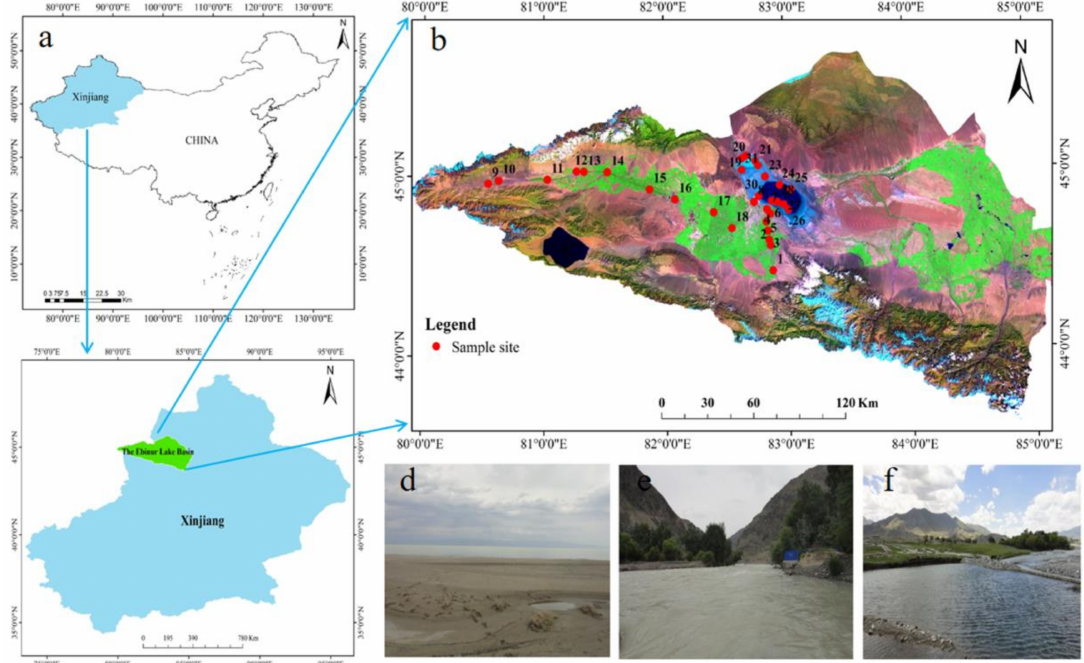
Figure 1. ( a ) Map of the locations of the Xinjiang Autonomous Region within China; ( b ) map of the study area in the Xinjiang Autonomous Region; ( c ) map of the research area and sampling points; ( d ) picture of Ebinur Lake; ( e ) picture of the Jing River; ( f ) Picture of Bortala River (photographed by Xianlong Zhang, Map by ArcGIS 10.2.2 (Environmental Systems Research Institute, RedLands, CA,